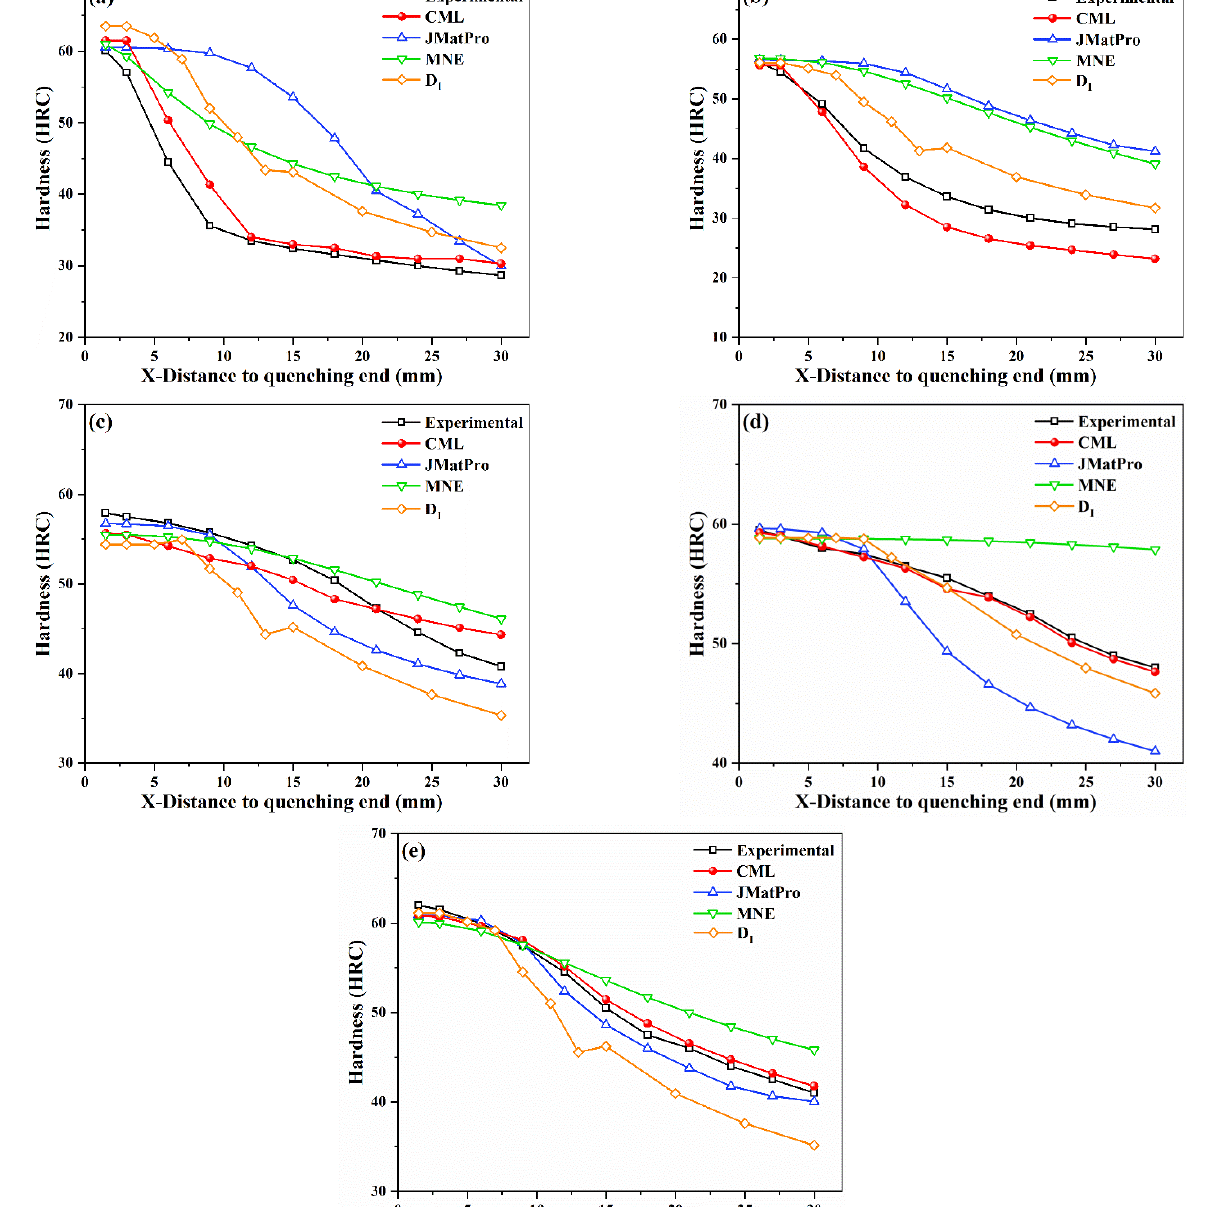
Figure 9. Comparison of experimental and predicted hardenability curves of steels by CML, JMatPro, MNE, and 𝐷 𝐼 ; ( a ) #1-5SiMnMoV; ( b ) #2-42SiMn; ( c ) #3-40CrNiMoA; ( d ) #4-45CrMnMo; ( e ) #5-50CrMnVA.